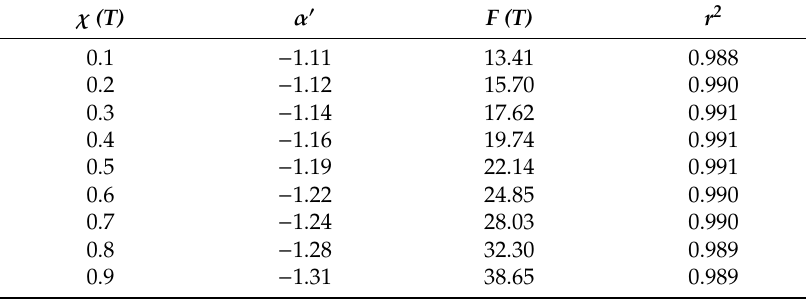
Figure 6. Plots of log ϕ versus log (t − t 0 ) at the indicated crystallinities for non-isothermal crystallization of P4HB. Table 2. Values of kinetic parameters at a given crystallinity estimated from the combined Liu model for non-isothermal crystallization of P4HB. 1